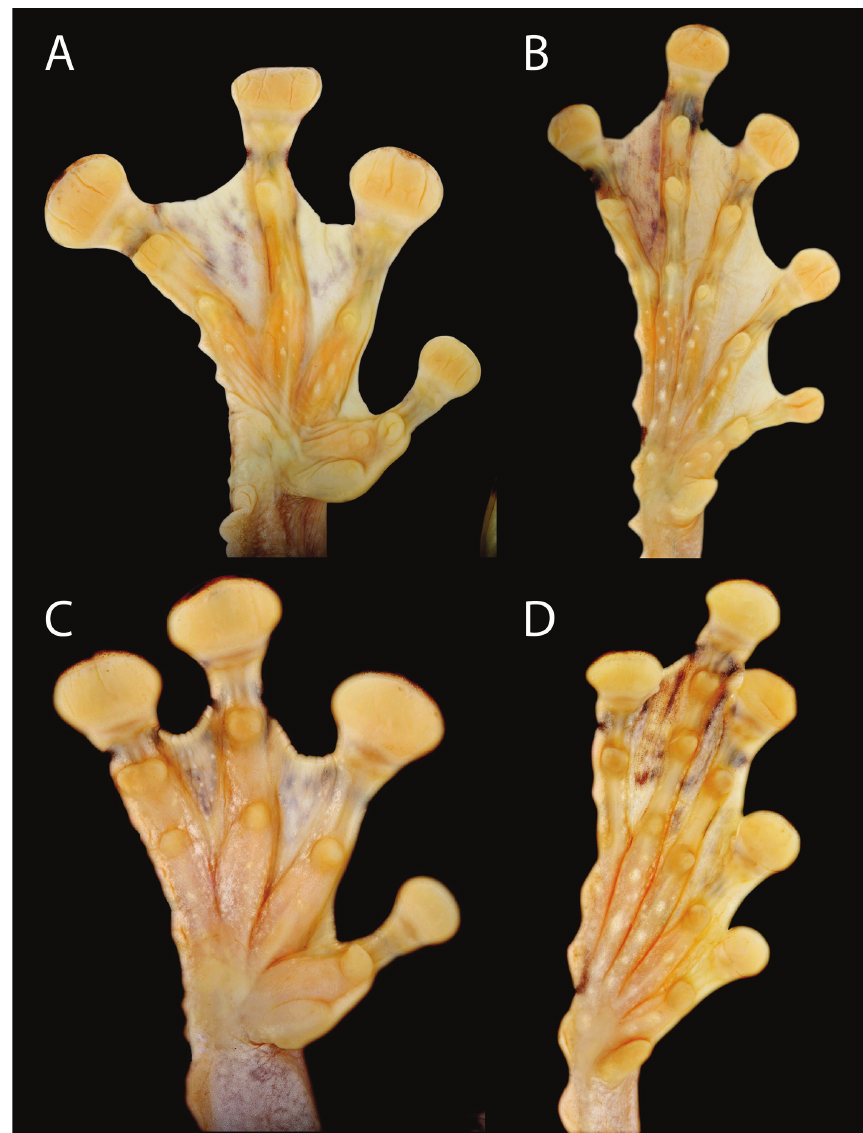
Figure 7. Ventral views of the left hand and foot of Tepuihyla . A–B Tepuihyla tuberculosa comb. n. (Parque Nacional Yasuní, Ecuador, SVL = 86.2 mm, QCAZ 52855, adult male) C–D Tepuihyla shushupe sp. n. (Ere River, Peru, SVL = 85.4 mm, CORBIDI 12513, adult male). scattered dark brown marks, ventrally greenish orange. Venter whitish gray with an orange tone on belly and ventral surfaces of thighs; ventral surfaces of arms and elbows greenish yellow; ventral surfaces of tibia, tarsus, palms, fingers, soles, toes and discs water green; limb bones green; iris cream with red periphery and irregular black